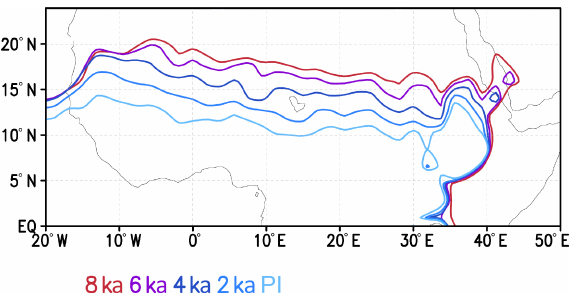
Figure 9. Change of the northernmost extent of the monsoon rain- band, based on the simulated 2mmd − 1 annual mean precipitation